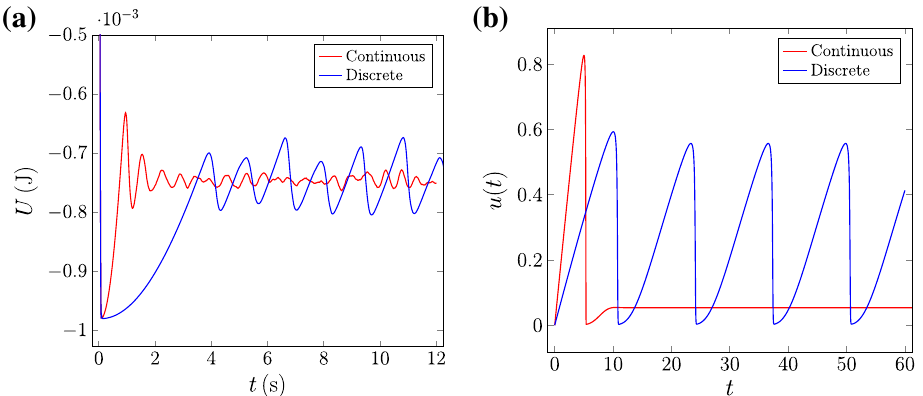
Figure 4. ( a ) Potential energy of the system for both continuous and discrete regimes. The discrete regime corresponds to A = 0.8 µ m and (cid:31) = 2 rpm , whereas the continuous regime corresponds to A = 0.8 µ m and (cid:31) = 10 rpm . ( b ) Numerical solution of u ( t ) to the proposed theoretical model for ǫ = 0.01 , A = 0.8 and (cid:31) = 2 and